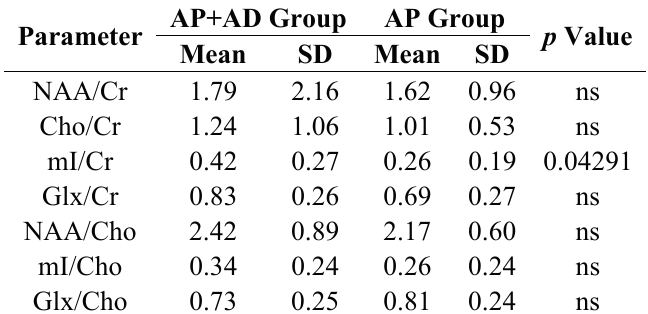
Table 5. Comparison of substance concentration ratios in left frontal WM.